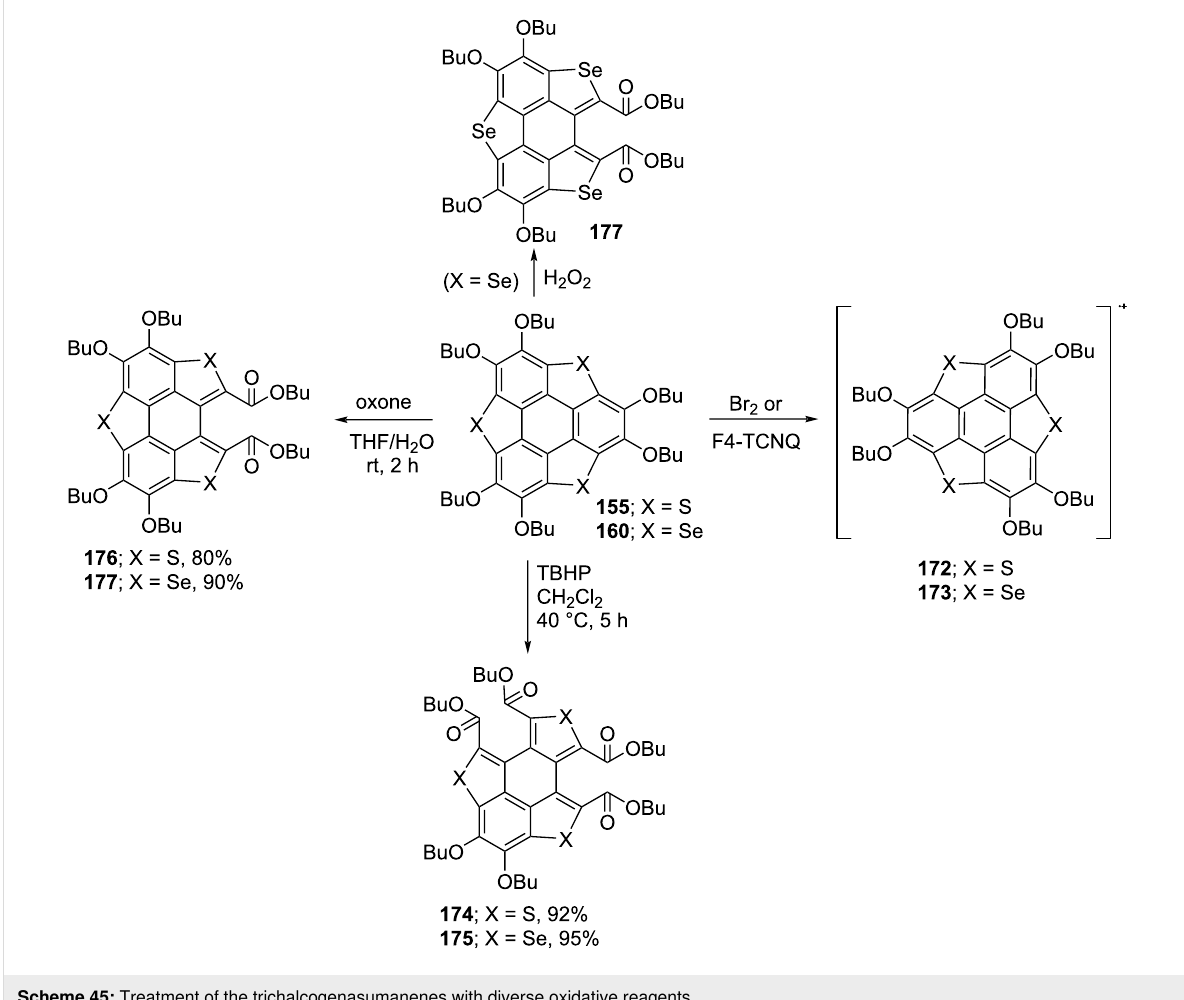
Scheme 45: Treatment of the trichalcogenasumanenes with diverse oxidative reagents.